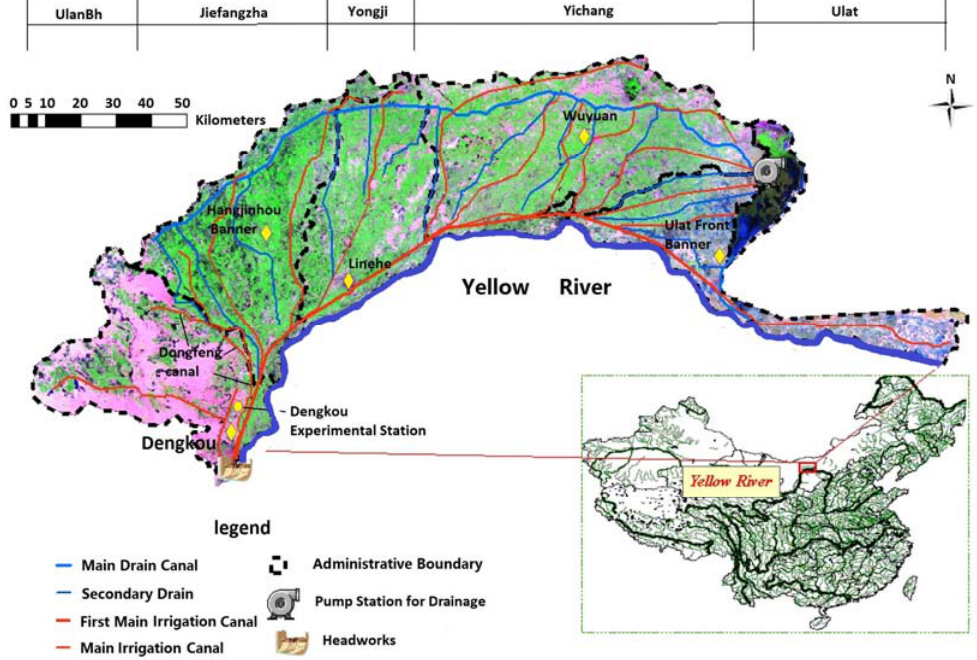
Figure 1. Map of the Hetao Irrigation District with representation of: ( a ) main irrigation drainage canals, ( b ) cropped areas, in green; ( c ) location of the Dengkou experimental area (Wu et al. [18]). Water diverted from the Yellow River for irrigation totals about 5.2 billion m 3 year − 1 [41,42]. To